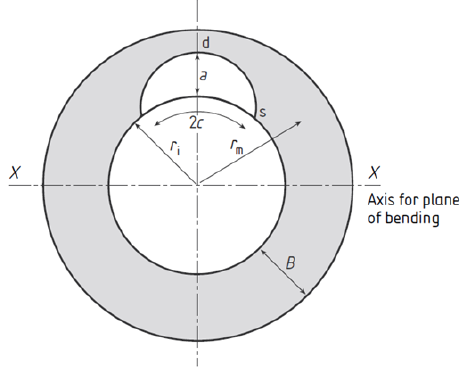
Figure 4: Surface flaw of internal cylinder.